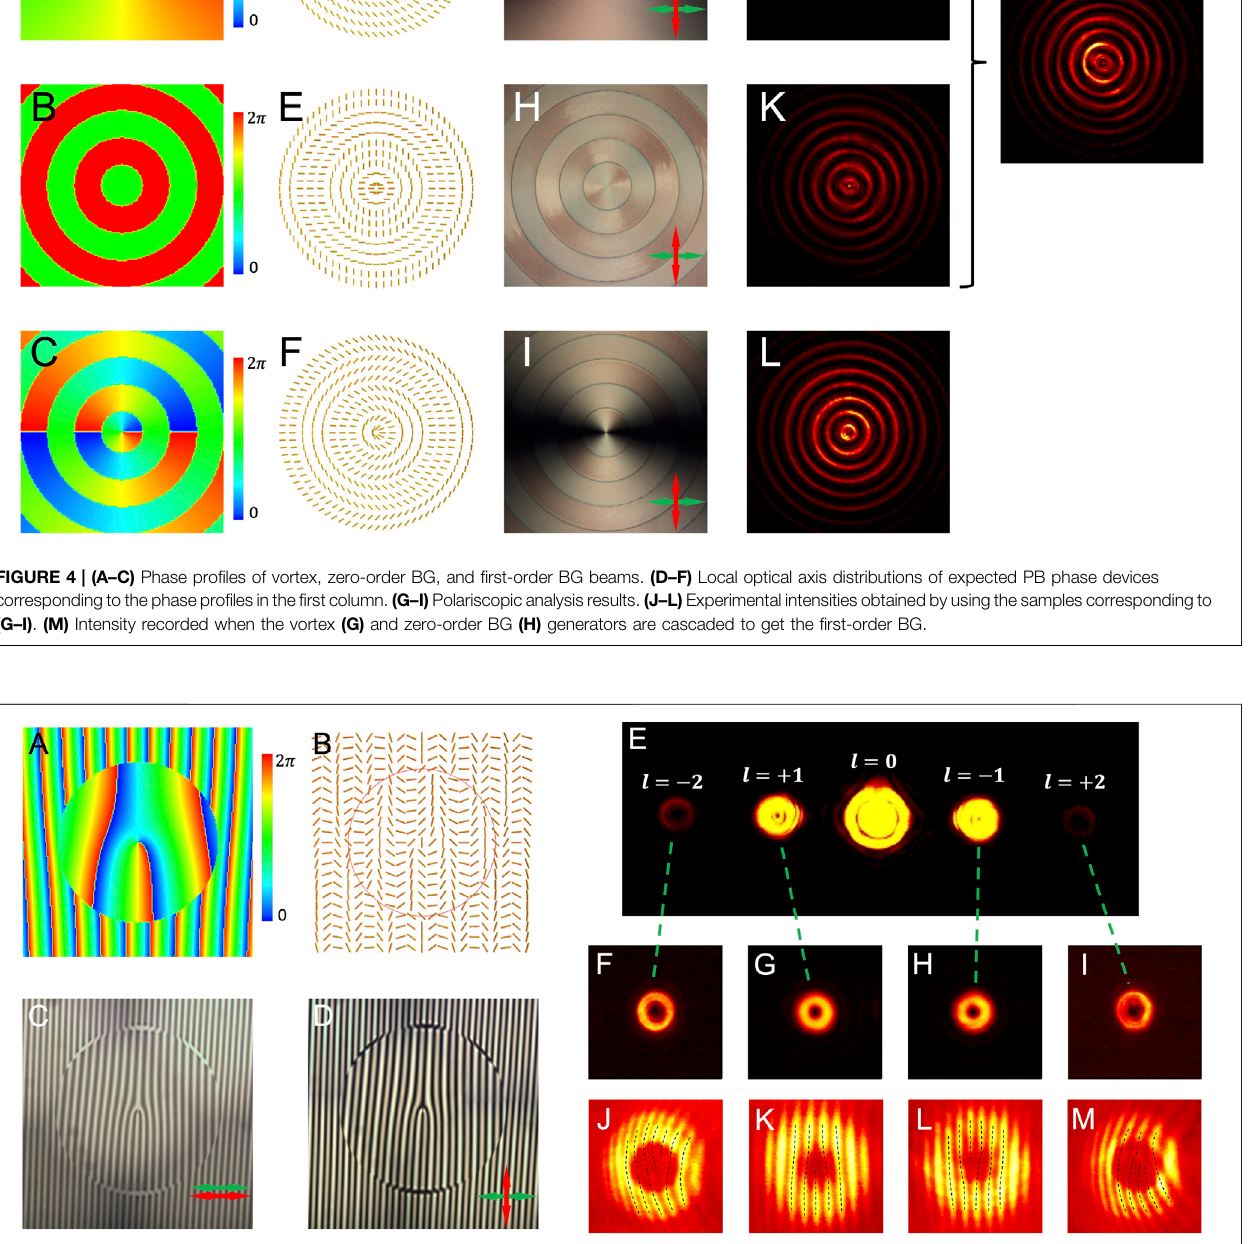
FIGURE 5 | (A) Phase pro fi le with two distinct parts along its radial direction. The inner part is designed with OAM l (cid:2) 1 and linear gradient with period Λ (cid:2) 180 μ m , while the outer part with l (cid:2) − 2 and Λ (cid:2) 180 μ m . (B) Desired local optical axis distribution. (C,D) Polariscopic analysis pictures of the real splitter. (E) Intensity pattern observedwhenaGaussianbeamimpingesthesplitter. (F – I) Individualintensitypatternsrecordedforeachseparatedmodeby fi lteringtheotherpartsoftheoutputlight. Ring patterns with adarkcenteraredemonstrated. (J – M) InterferenceswithageneralGaussianbeam are implemented, whichimply theSAM and OAMmodes of each component. The mismatches in interference fringes indicate the order of topological charge (OAM), while the orientation of the fork patterns reveals its sign (SAM).